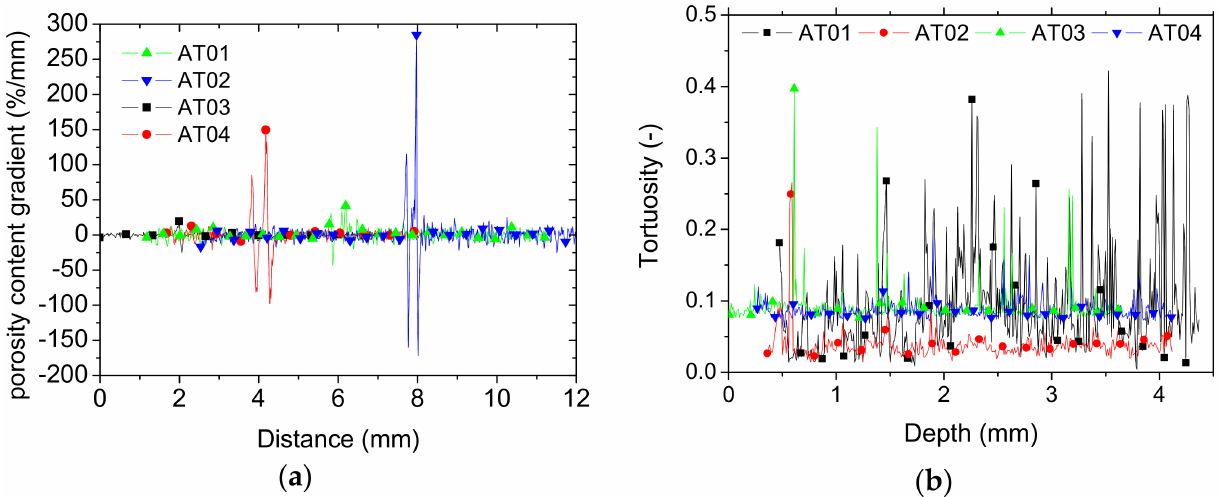
Figure 11. Results of porosity analysis: ( a ) gradient of porosity content across the interface and ( b ) in- terfacial tortuosity through the depth of the printed ABS/TPU composite for all printing